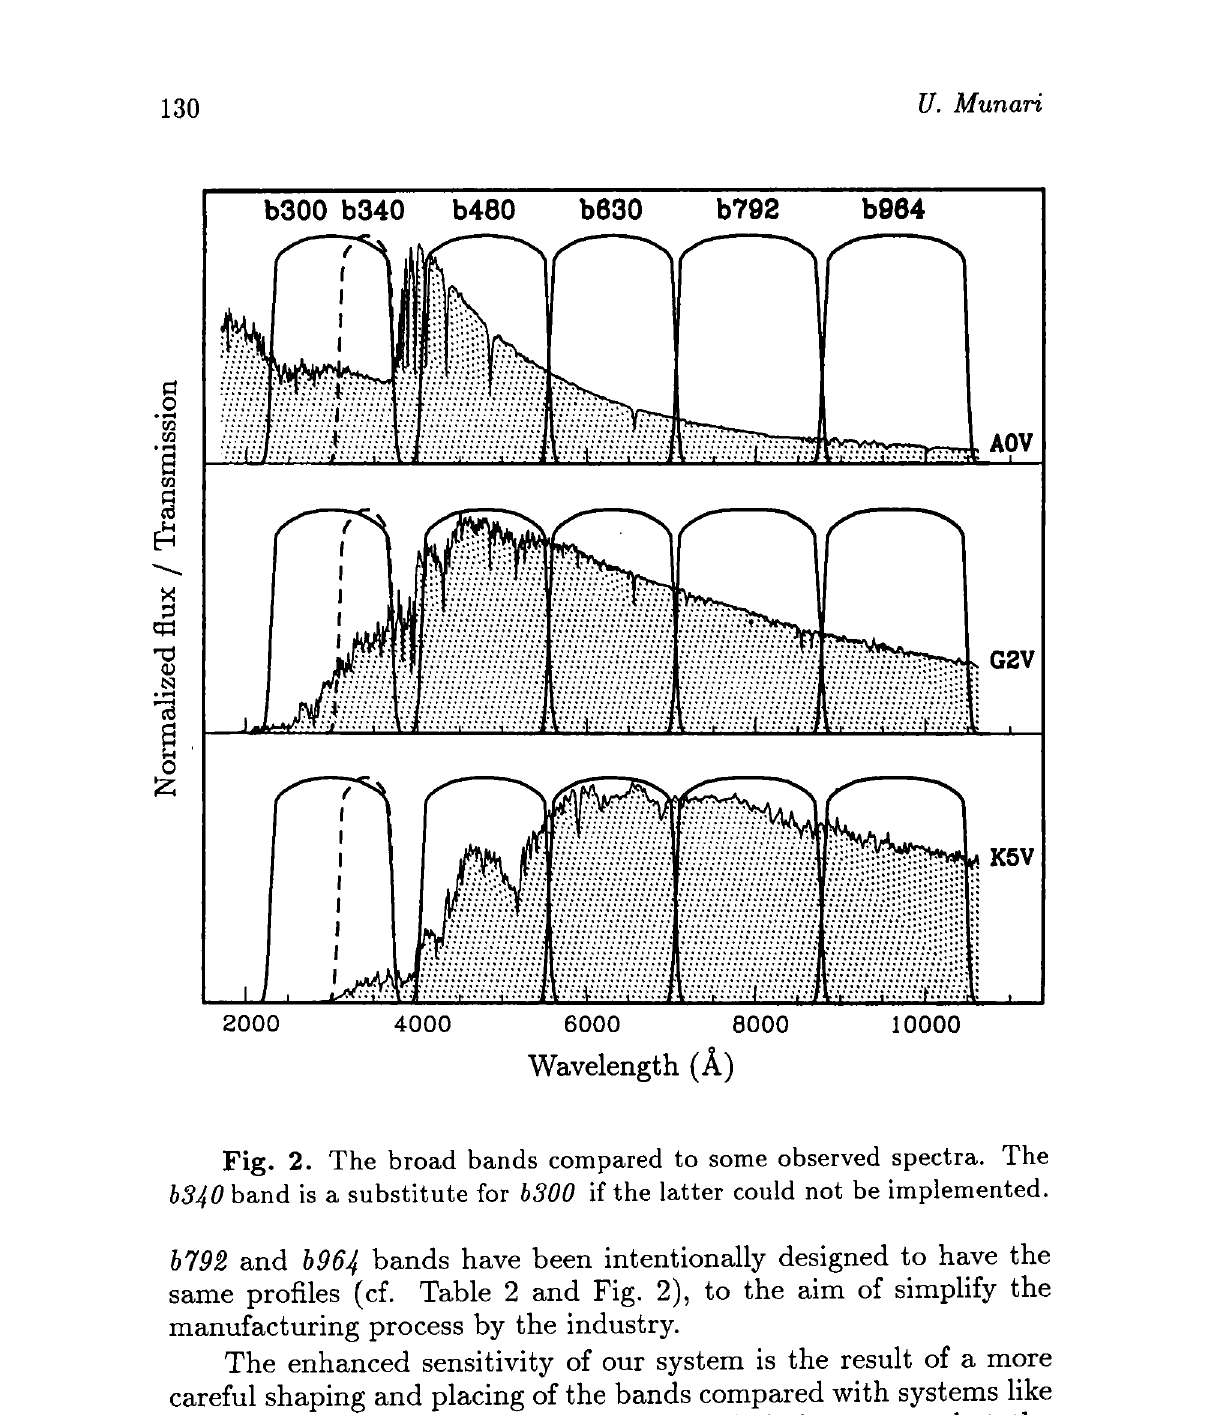
Fig. 2. The broad bands compared to some observed spectra. The b340 band is a substitute for b300 if the latter could not be implemented. b792 and b964 bands have been intentionally designed to have the same profiles